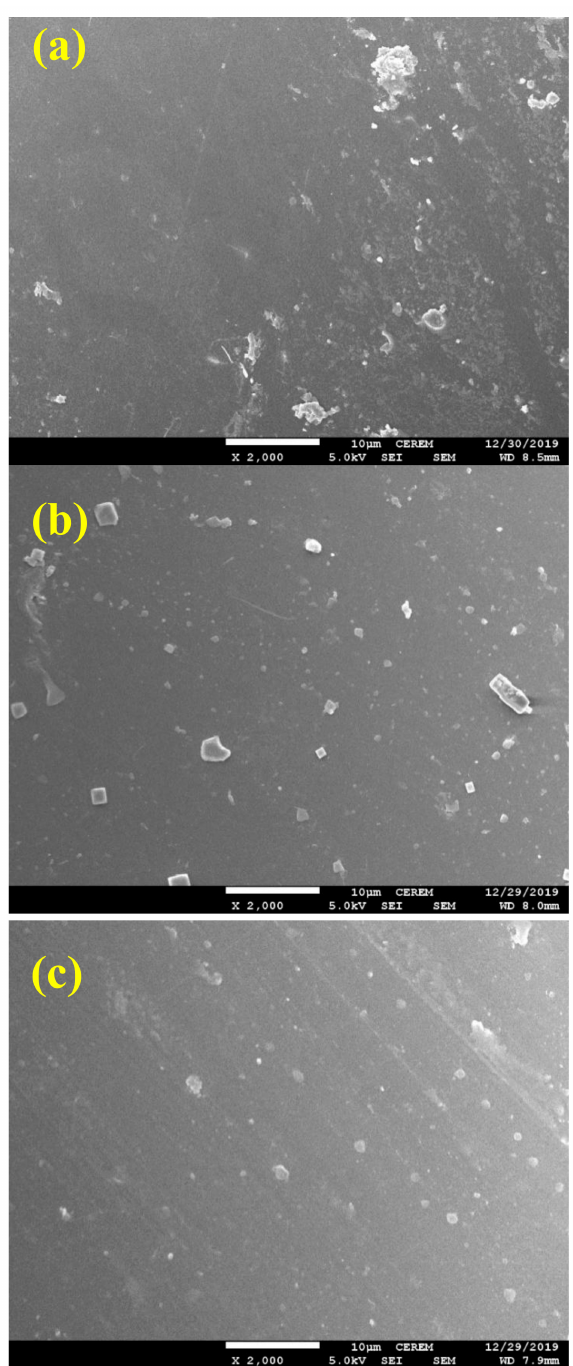
Figure 13. SEM micrographs obtained for the surface of ( a ) SN1, ( b ) SN3, and ( c ) SN5 epoxy coatings after their immersion for 30 days in 3.5% NaCl